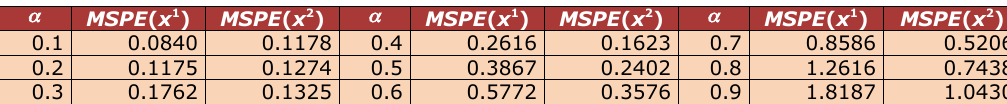
Table 2. MSPE ( x 1 ) and MSPE ( x 2 ) under different values of a